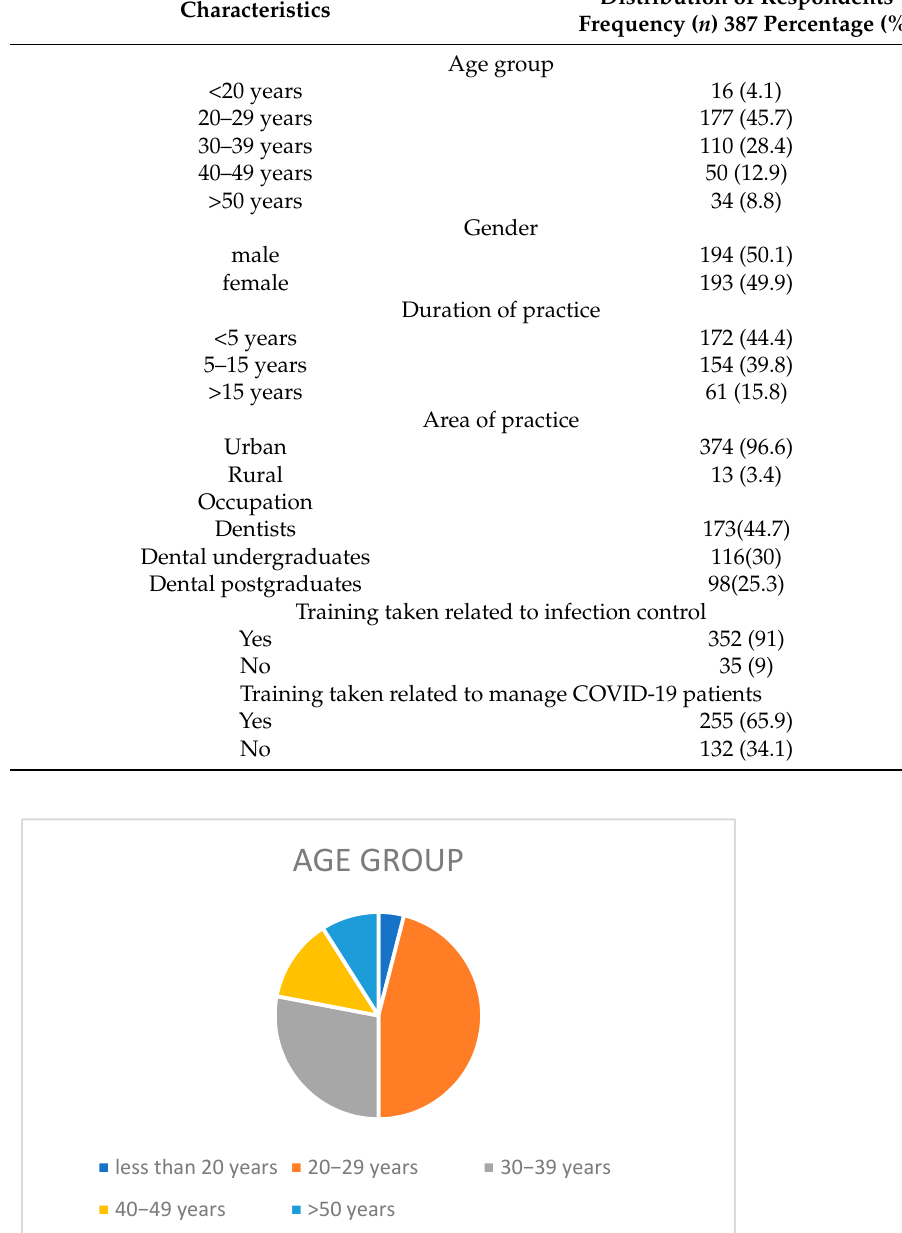
Table 1. Distribution of participants based on demographic characteristics.